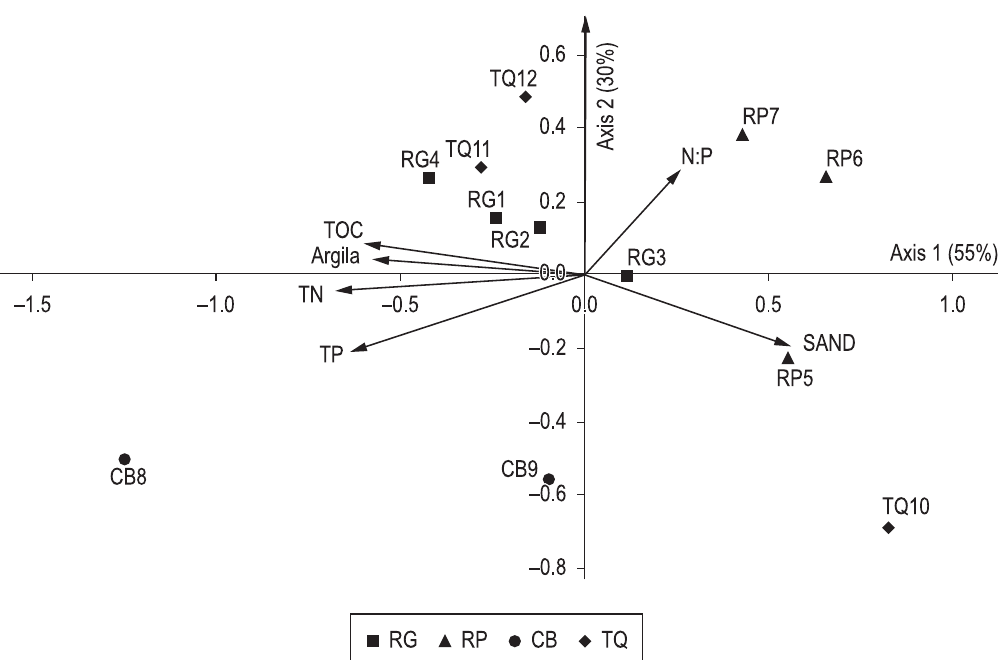
Figure 7. PCA biplot of surface sediment variables and scores for the sampling sites during the winter (RG: Rio Grande Reservoir, RP: Rio Pequeno branch, CB: Central body, TQ: Taquacetuba branch). For correlation of variables with principal components and respective codes see Table